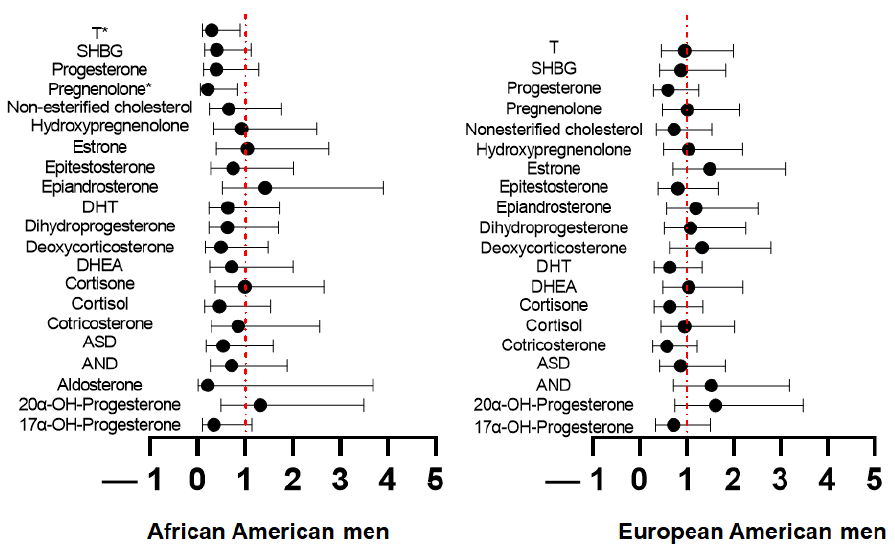
Figure 4. Testosterone (T) and pregnenolone levels are associated with shorter progression-free survival (PFS) only in African American (AA) men. The association between survival outcomes and the dichotomized metabolites was examined by race using Cox regression models and fit using Firth’s method. Higher levels of testosterone and pregnenolone were associated with decreased risk of progression-free survival only in AA men. The circles represent the hazard ratios and the lines represent the 95% confidence intervals. SHBG: Sex hormone binding globulin, DHT: Dihydrotestosterone, DHEA: Dehydroepiandrosterone, ASD: Androstenedione, and AND: All observed Androsterone. * p < 0.05.